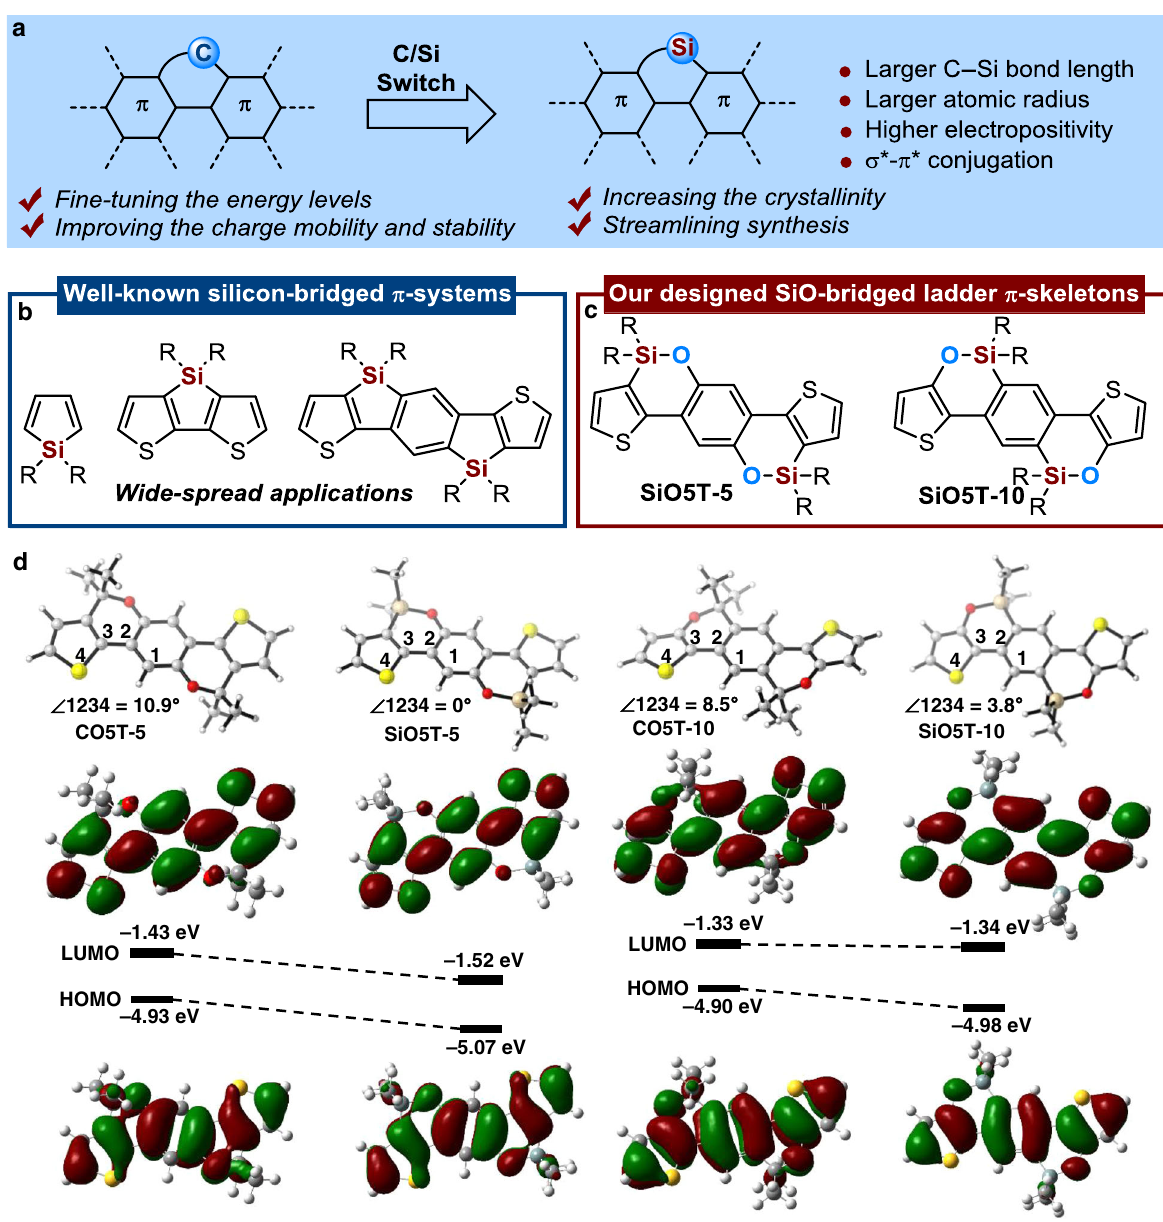
Fig. 1 Design and development of 6-membered SiO-bridged ladder-type units. a The advantage of incorporating silicon into π -systems. b Well-known silicon-bridged π -systems. c Our design on 6-membered SiO-bridged ladder-type units. d The molecular geometries and electron distributions of frontier orbitals of SiO5Ts and their carbon-analogs CO5Ts